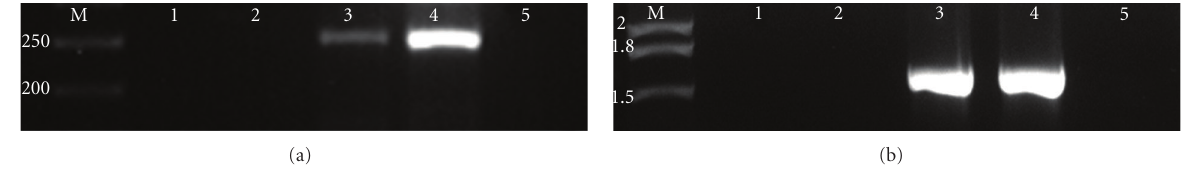
Figure 1: Di ff erential expression of pmt of A. baumannii AIIMS 7 (a) expression of pmt. Lane 1: direct PCR using total RNA from planktonic cells (nonadherent) of A. baumannii AIIMS 7; Lane 2: direct PCR using total RNA from biofilm cells (adherent) of A. baumannii AIIMS 7; Lane 3: RT-PCR using total RNA from planktonic cells (nonadherent) of A. baumannii AIIMS 7. Lane 4: RT-PCR using from biofilm cells (adherent) of A. baumannii AIIMS 7 cells (b) Expression of internal control 16SrDNA gene. Lane 1: direct PCR using total RNA from planktonic cells (nonadherent) of A. baumannii AIIMS 7; Lane 2: direct PCR using total RNA from biofilm cells (adherent) of A. baumannii AIIMS 7; Lane 3: RT-PCR using total RNA from planktonic cells (nonadherent) of A. baumannii AIIMS 7; Lane 4: RT-PCR using from